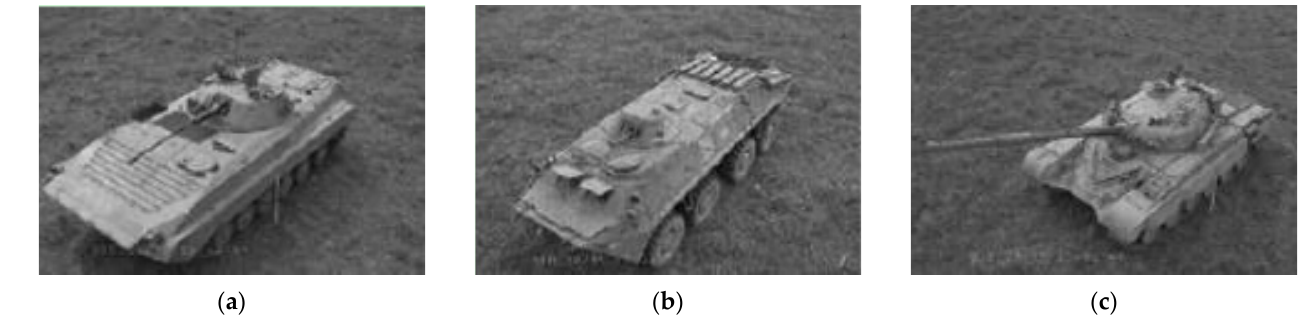
Figure 3. Visible light images for three targets in the MSTAR database. ( a ) BMP2. ( b ) BTR70. ( c ) T72. Table 1. The dataset of training and testing